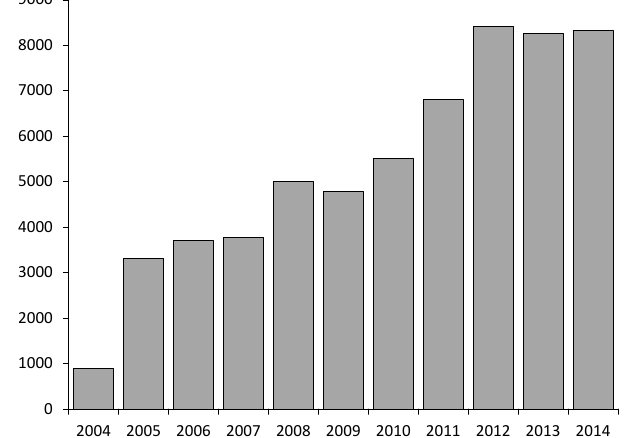
Figure 3. Average monthly downloads per year (source: Source- Forge.net,